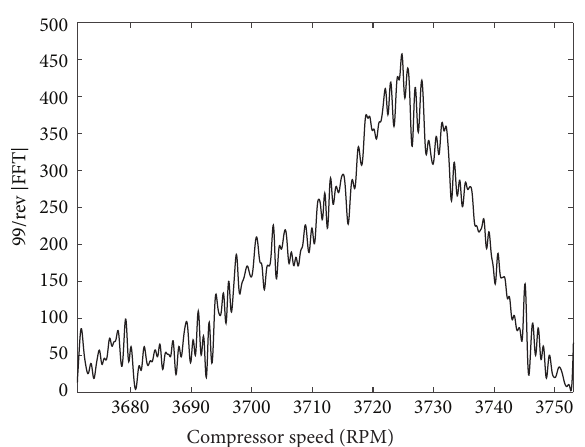
Figure14:Themagnitudeofthespectralcomponentassociatedwith the 99/rev frequency at high